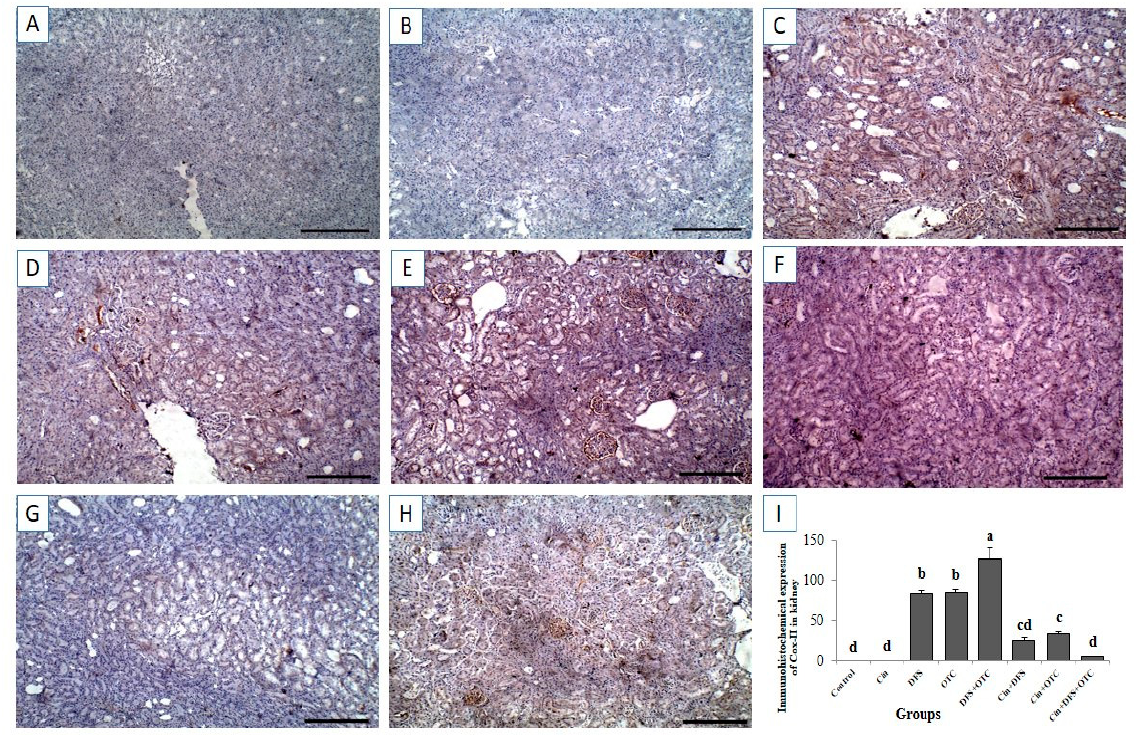
Figure 9. Immunohistochemical staining of rat kidney by Cox-II. ( A , B ) control and cinnamon groups: Showing negative Cox-II reaction in the renal sections. ( C , D ) DFS and OTC groups: Revealing strong positive Cox-II reaction in the hepatocytes. ( E ) DFS+ OTC group: Showing a higher expression level of Cox-II relative to those in rats treated with DFS or OTC alone ( F , G ), DFS + Cin, and OTC + Cin group: Revealing reduction in immune reactivity of Cox-II. ( H ) DFS + OTC + Cin group: Showing moderate positive Cox-II immune staining. ( I ) Quantification of Cox-II in the kidney tissues in different groups. Data are presented as the mean ± SEM (n = 5), analyzed using one way ANOVA and each bar carrying different letters (a, b, c, d) is significantly different ( p < 0.05). Scale bar = 100 µm.